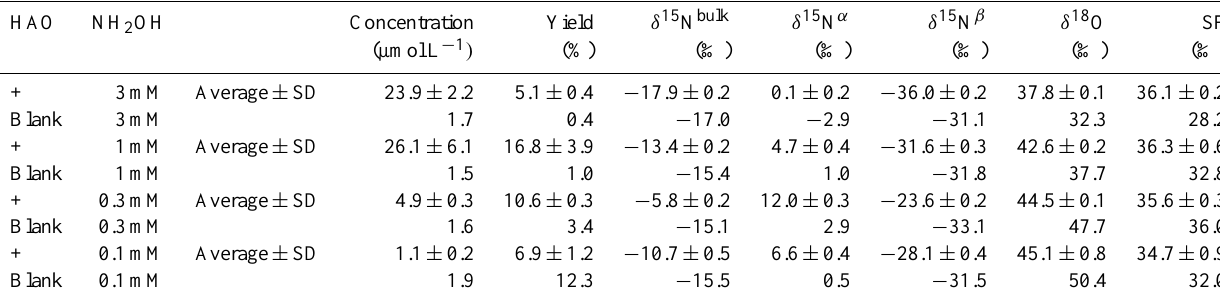
Table 1. Concentration and isotopomer ratios of N 2 O produced during NH 2 OH oxidation by HAO enzyme extracted from N. oceani with different concentrations of NH 2 OH.